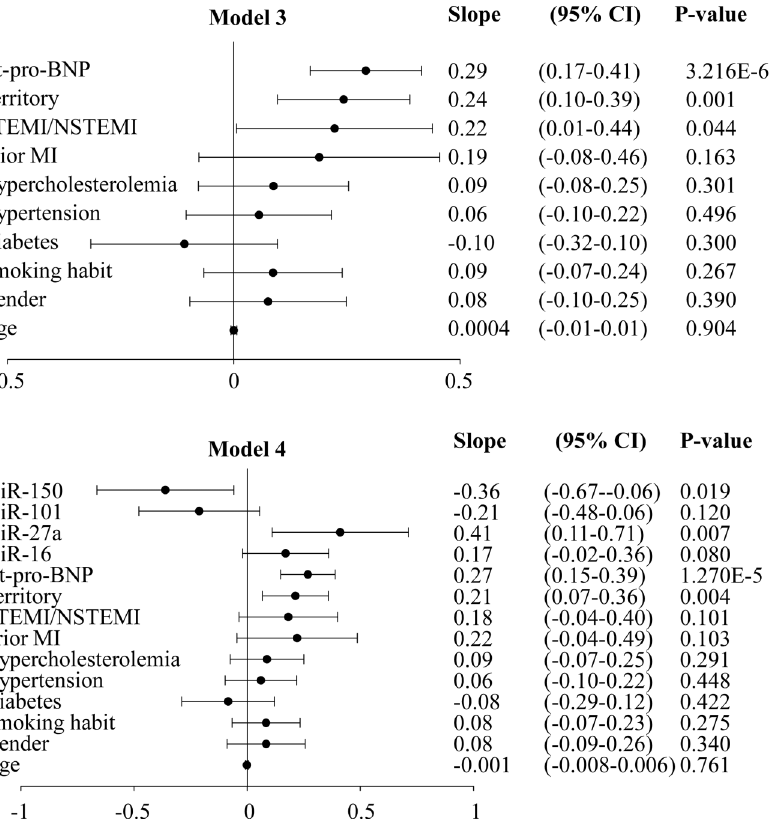
Figure 3. Rates of change in WMIS obtained by censored regression. Nt-proBNP and miRNAs were measured at discharge from the hospital and LV contractility was evaluated by WMIS at 6-months follow-up. Censored regression models were built to determine LV contractility. A. Model 3 is a multivariable model including indicated clinical parameters and Nt-proBNP. B. Model 4 is a multivariable model including the variables of model 3 and the expression values of miR-16/27a/101/150. CI: confidence